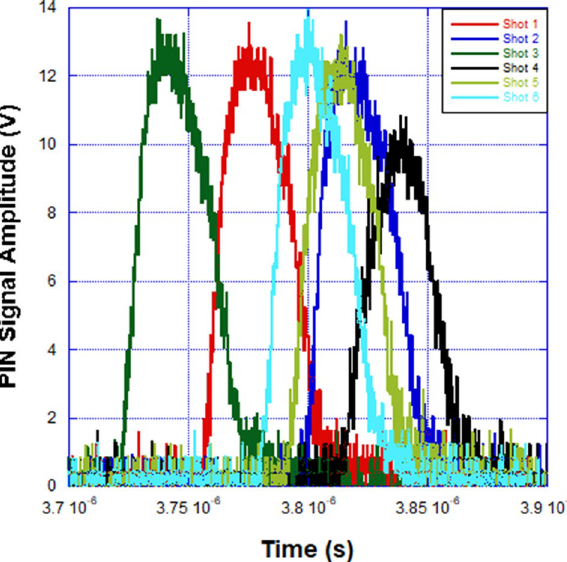
Figure 5. PIN diode signal amplitude versus time for a series of six shots on the HERMES III pulsed power accelerator. The average signal amplitude and pulse width (excluding shot #4) were 13.73 V and 32.24 ns